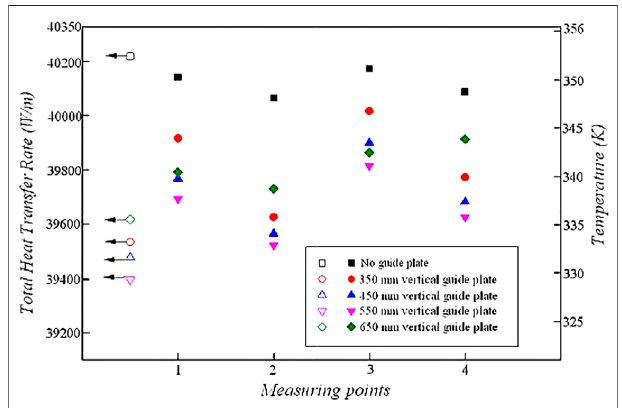
FIGURE 10 | The impact of vertical guide plates on total heat transmission and average temperature at the convective tube bundle.